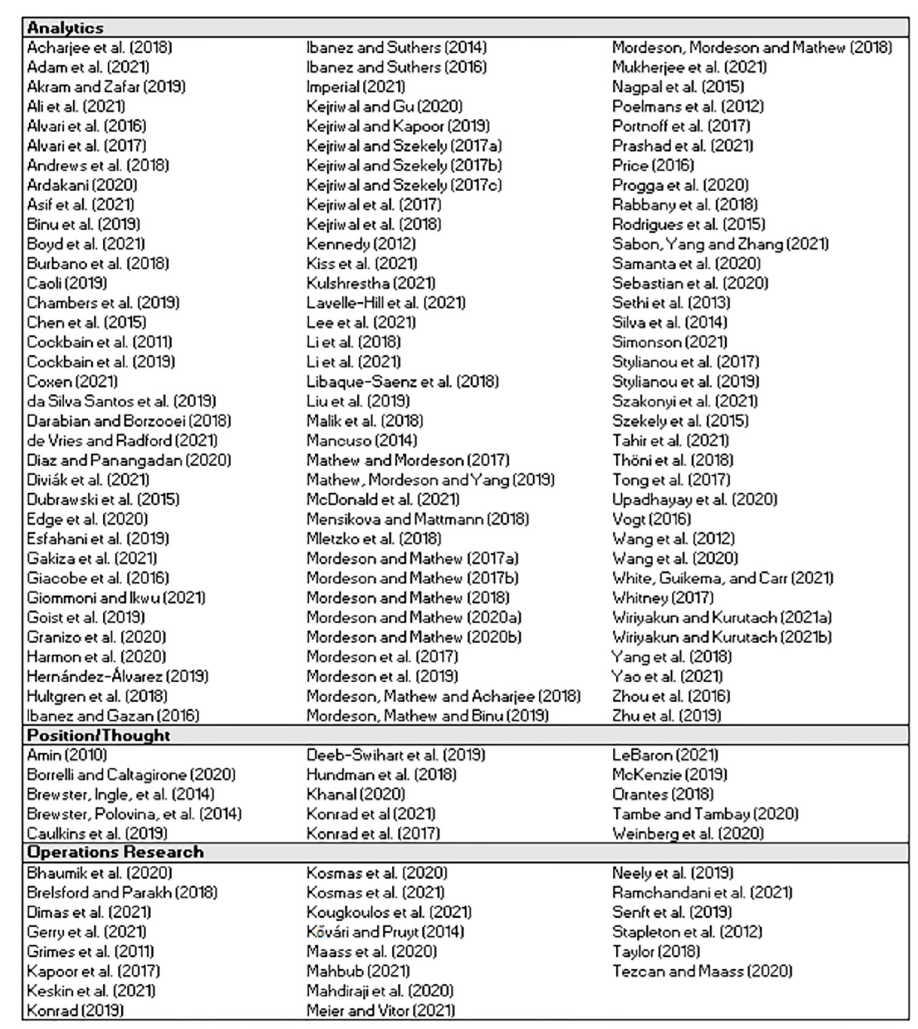
Fig 3. Category classification for the set of 142